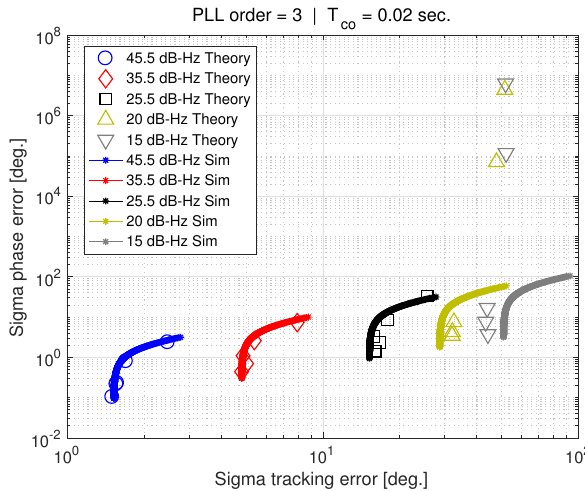
Figure 11. Sigma phase error vs. sigma tracking error, for T co = 20